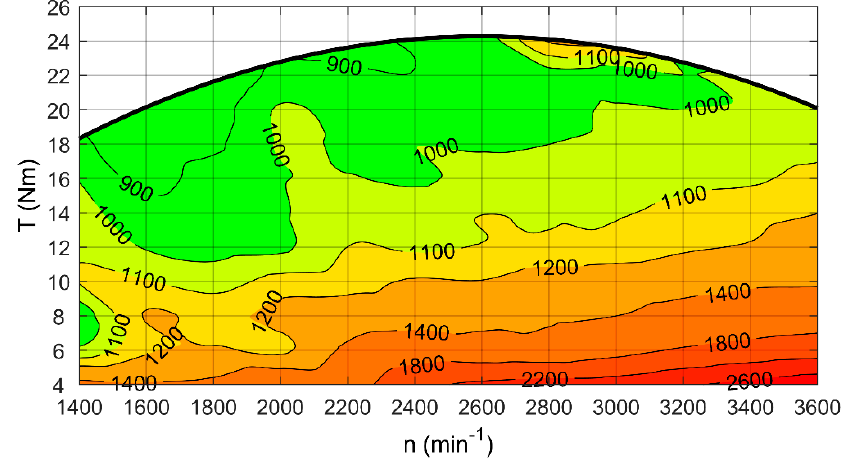
Figure 11. CO 2 emission (g/kWh) from the range extender supplied with gasoline.